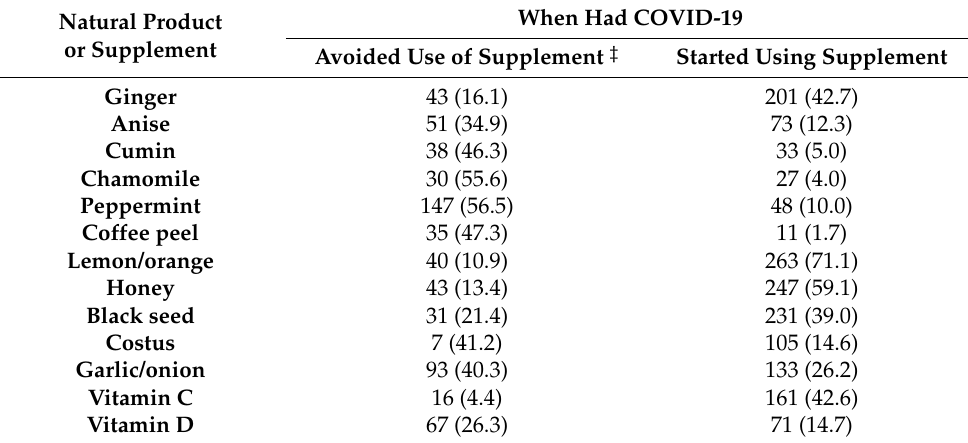
Table 3. Change in patients’ behavior during infection with COVID-19 for previous consumers or nonconsumers of dietary or herbal supplements before